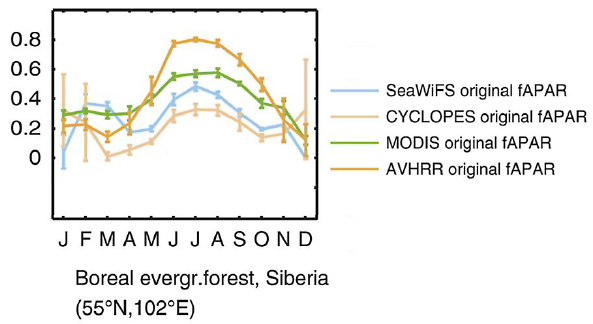
Fig. 2. Original fAPAR time series from a selected region (after Dahkle et al., 2012). © American Meteorological Society. Used with